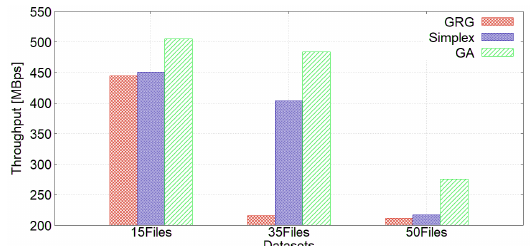
Figure 8. Write throughput using replication factor 3.